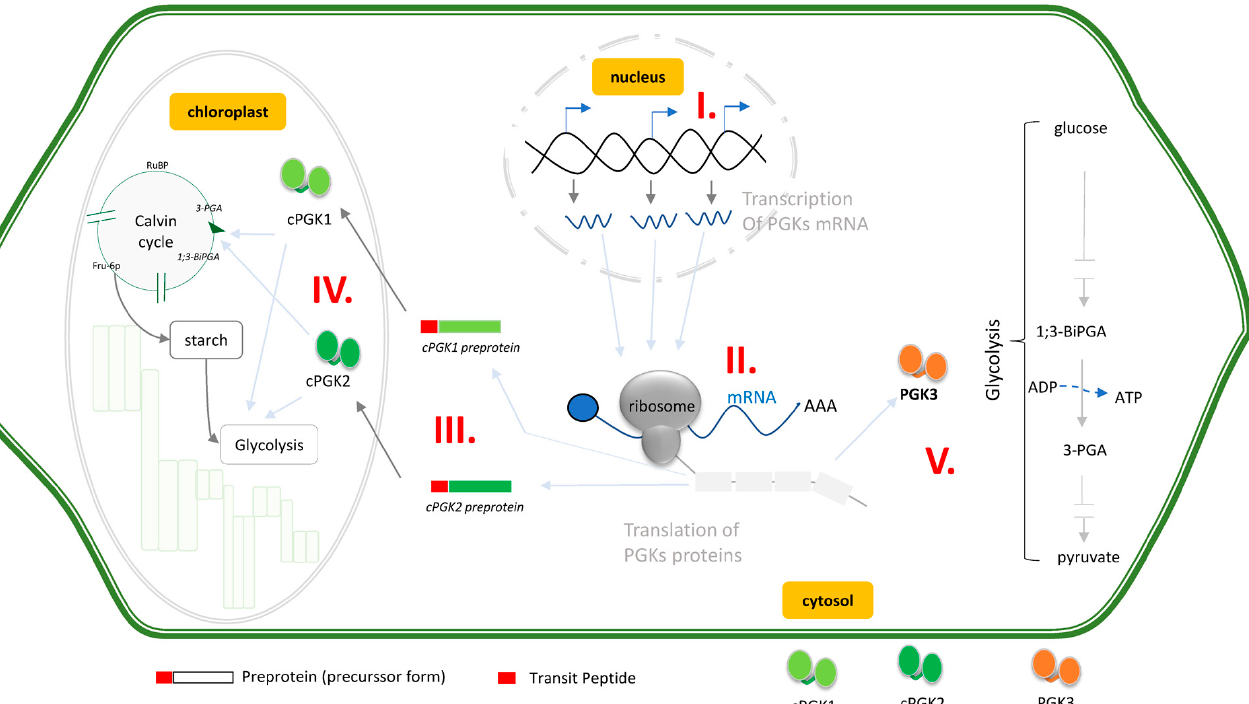
Table 1. Summary of phenotypic analyses of the current Arabidopsis PGKs mutants. The expression analysis of PGKs genes in each of these lines reveals that the cpgk1 (GK_172A12; GK_908E11) lines are knock down, while cpgk2 and pgk3 (SALK062377; SALK066422) lines are complete knockout [27].